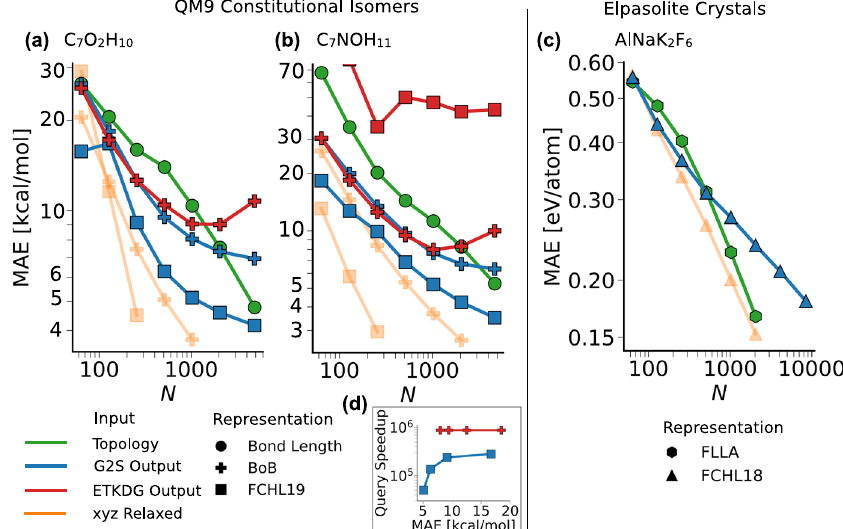
Fig. 6 Systematic improvement of energy prediction accuracy with increasing training data. G2S predictions (blue), as well as DFT structures (orange) and ETKDG/UFF structures (red), have been used as inputs to QML models. a , b atomization energy prediction of C 7 O 2 H 10 and C 7 NOH 11 constitutional isomers, respectively. c Prediction of formation energies of elpasolite crystals. d Speedup estimate of a G2S (blue) or ETKDG/UFF (red) based QML model